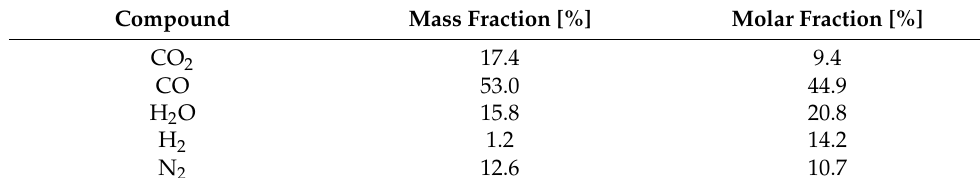
Table 5. Approximate propellant gas composition.